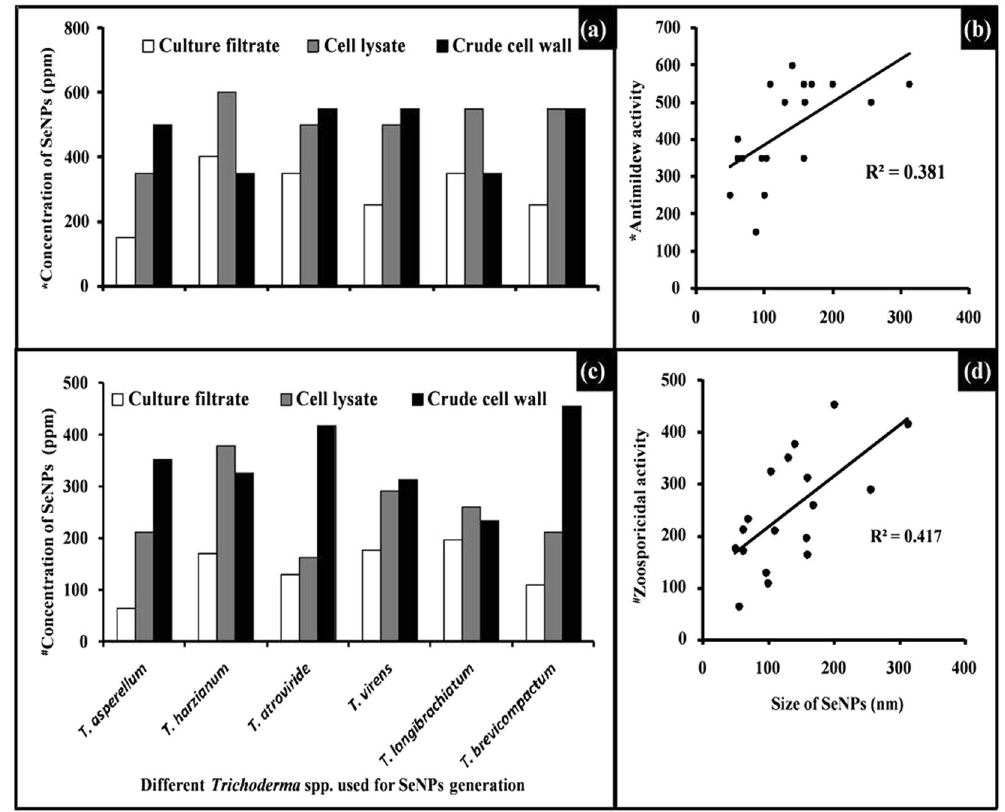
Figure 4. Anti-mildew and zoosporicidal activity of Trichogenic-SeNPs. ( a ) Anti-mildew activity of Trichogenic-SeNPs generated using CF, CL and CW of Trichoderma spp. ( b ) Correlation between anti-mildew activity and size of SeNPs. ( c ) Zoosporicidal activity of Trichogenic-SeNPs generated using CF, CL and CW. ( d ) Correlation between zoosporicidal activity and size of SeNPs. * Minimum concentration SeNPs showing complete inhibition of sporulation. # Concentration of SeNPs corresponding to IC 50 value. Valuesare means of three